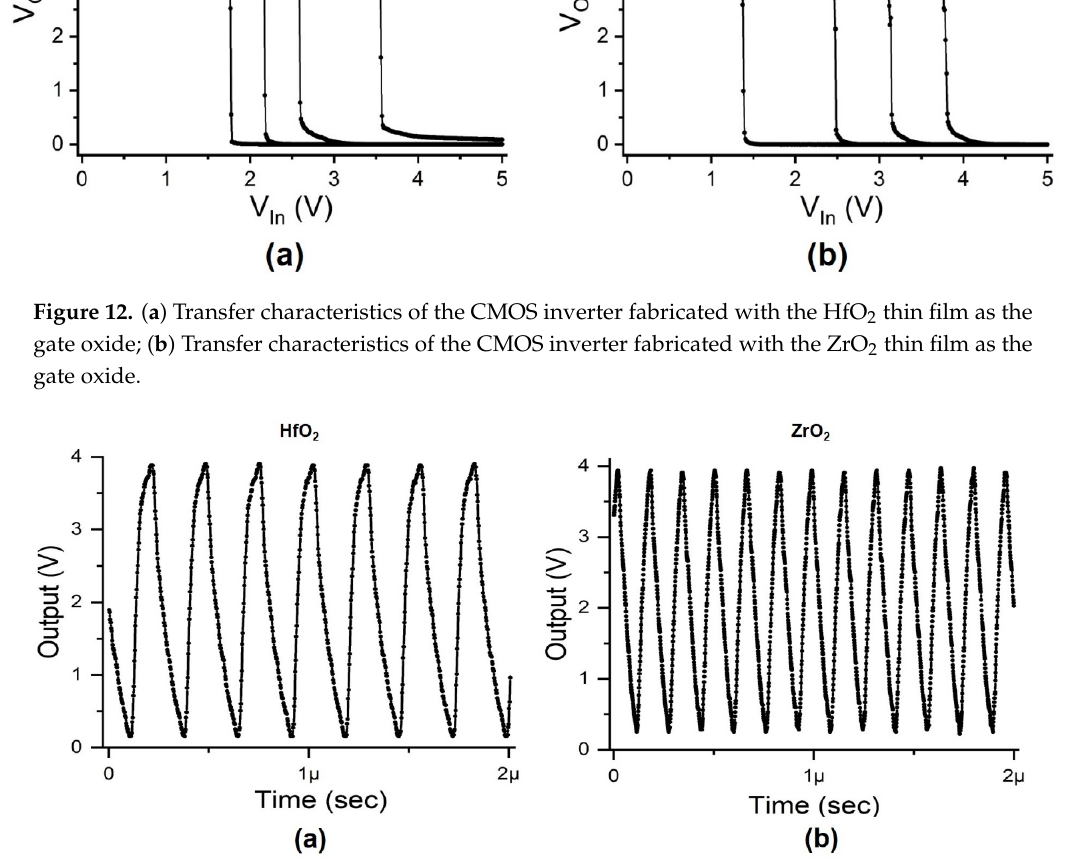
Figure 13. ( a ) The oscillation waveform of the HfO 2 -based CMOS ring oscillator at the voltage drain drain (VDD) supply voltage of 4V; ( b ) The oscillation waveform of the ZrO 2 -based CMOS ring oscillator at the VDD voltage of 4V.